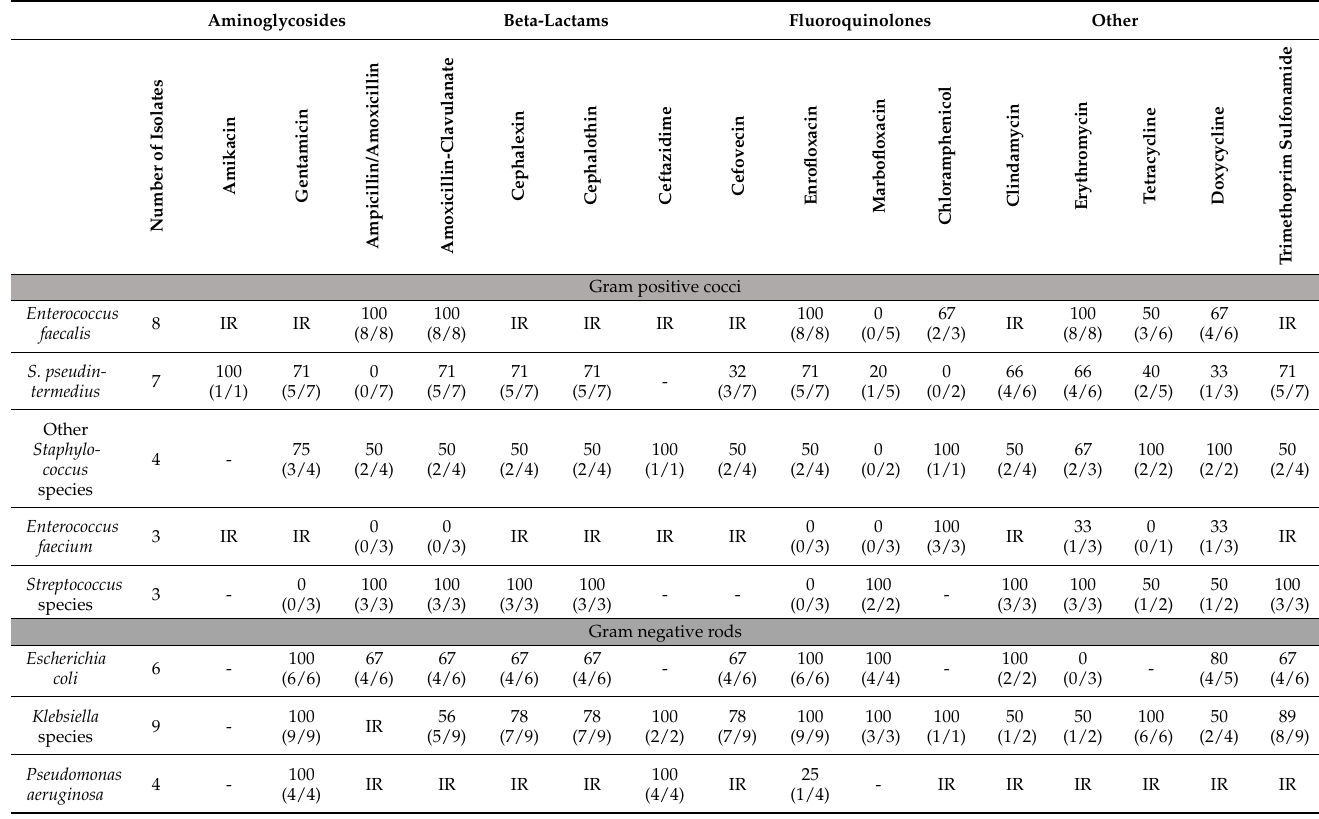
Table 2. Summary of microbes cultured from the airways of dogs and cats undergoing mechanical ventilation for tick paralysis, and their antimicrobial susceptibility patterns. Proportions and percent- ages of bacterial isolates considered susceptible to given antimicrobials are displayed. Bacteria are classified as Gram-positive cocci, Gram-negative rods, or other. Antimicrobials are classified by